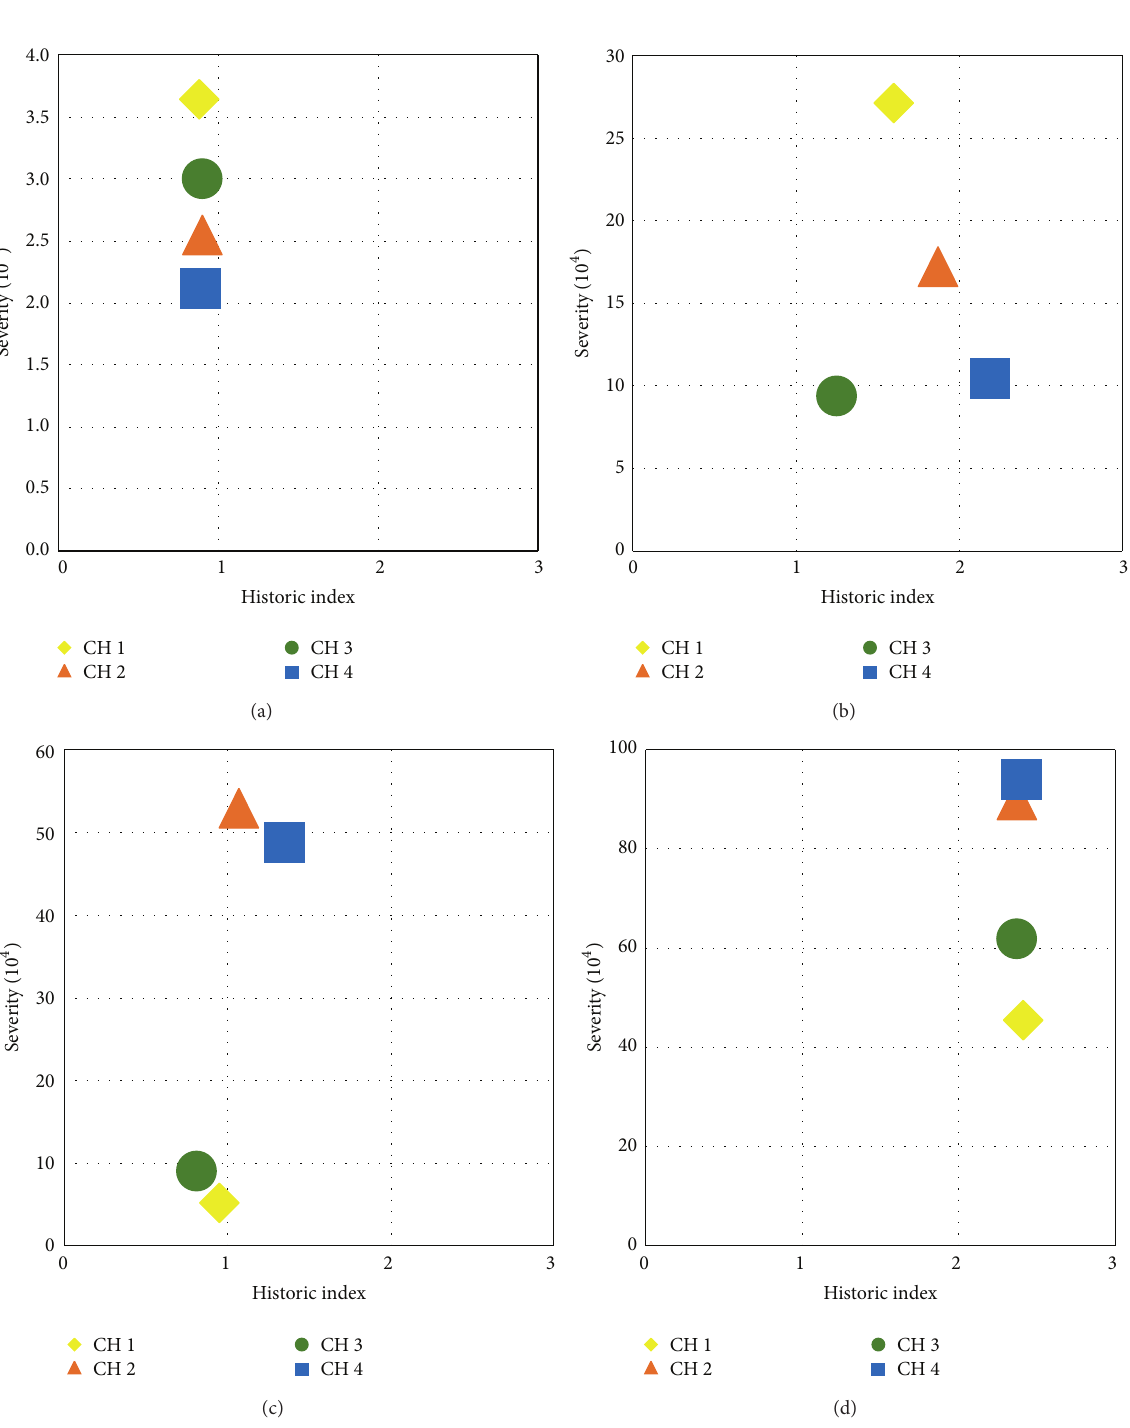
events such as macrocracking and rebar yielding occur, CSS experiences significant changes in the form of a knee in its curve. This study indicates that cumulative hits and signal strength correlate well with the degree of damage of speci- mens. Furthermore intensity chart was generated for the DC specimen up to the failure point. The results obtained from